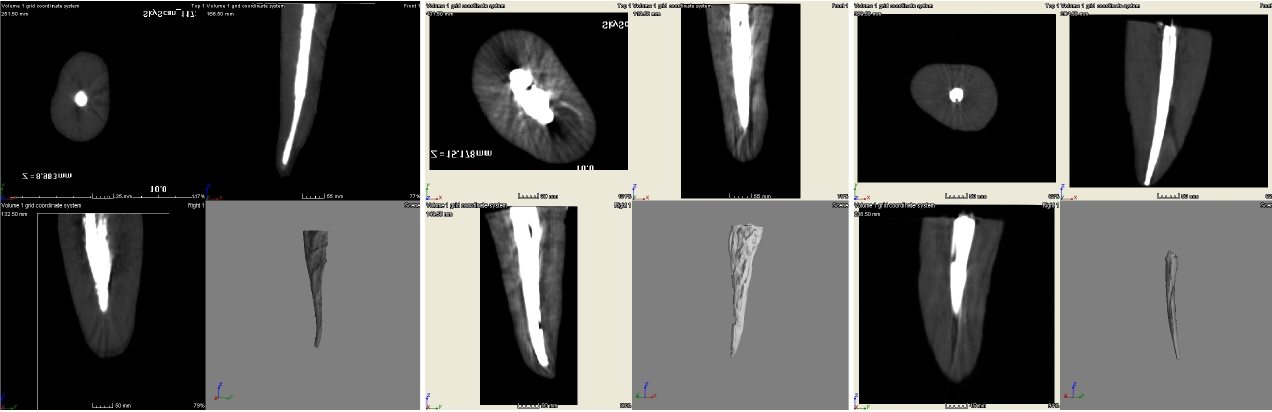
Fig. 2. Micro-computed tomography reconstructions of root canal geometry of samples filled with Nano-HA and Gp using cold lateral condensation technique (A), System B (B) and Down-Pak technique